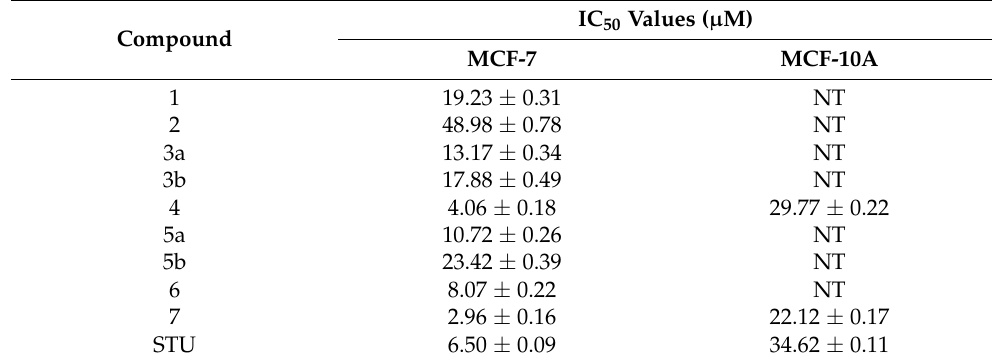
Table 1. Cytotoxic evaluation of compounds 2 – 7 against breast adenocarcinoma MCF-7 cell line and normal breast cells MCF-10A. Data expressed as the mean ± SD with n = 3 experiments.